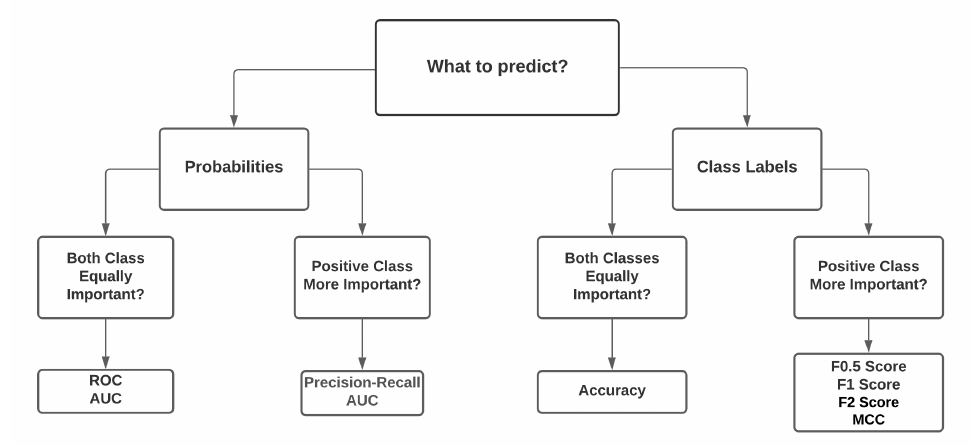
Figure 6. Selection process of the best evaluation metrics for different